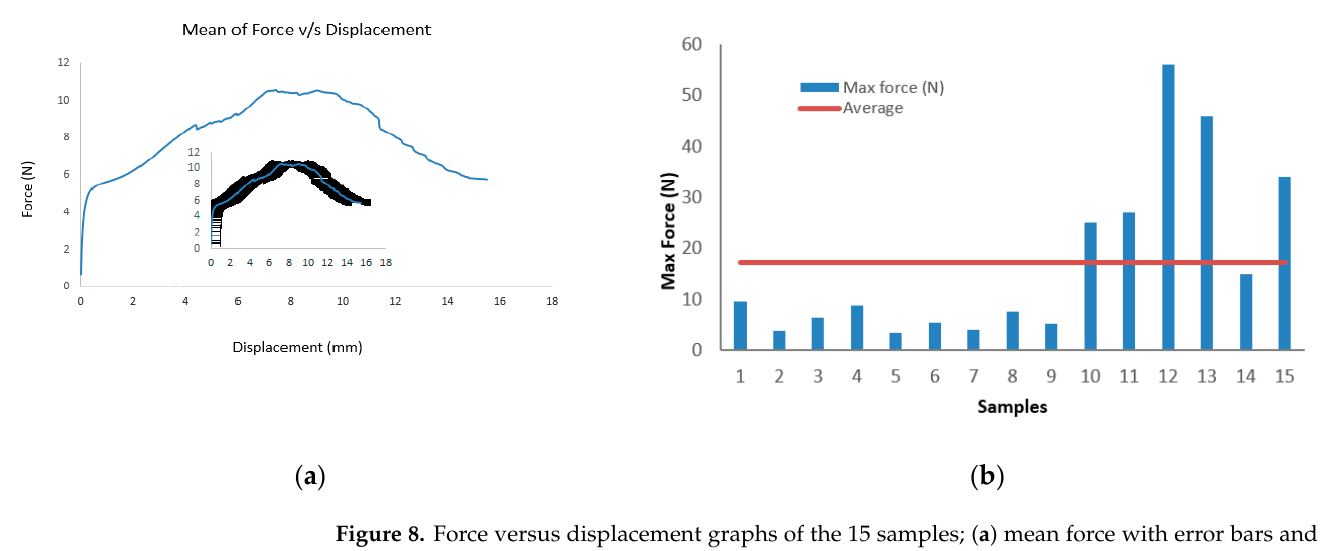
Figure 8. Force versus displacement graphs of the 15 samples; ( a ) mean force with error bars and ( b ) maximum force.